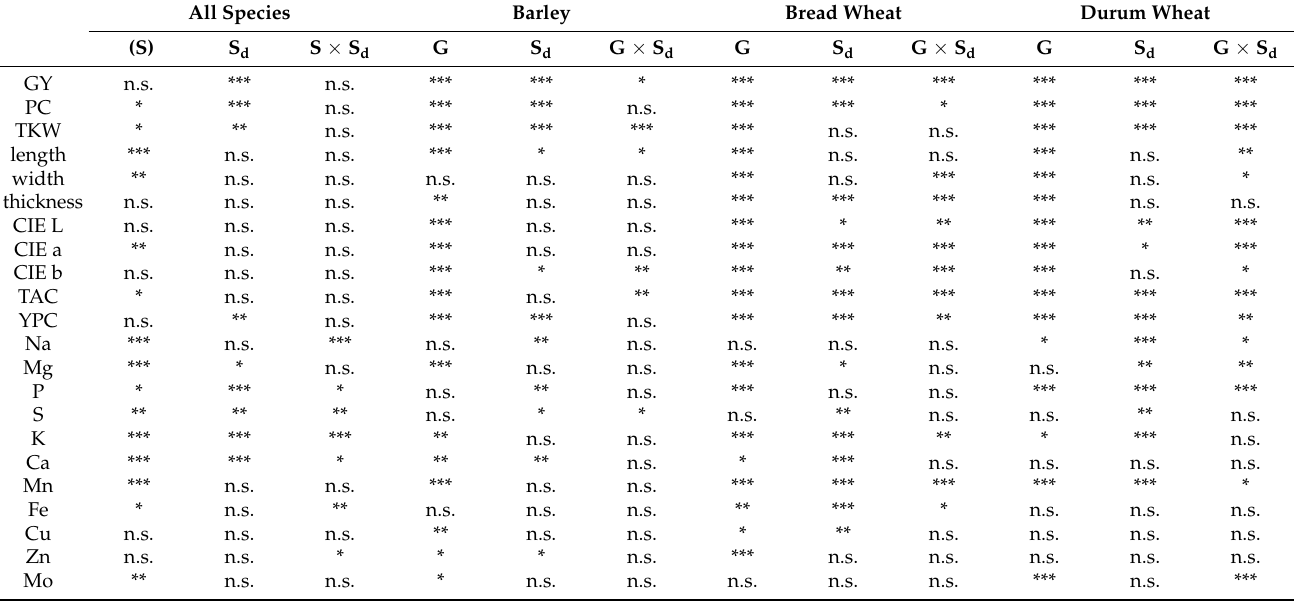
Table 4. Significances of the mean differences for each variable investigated relating to the whole data set and specific to each species, grown with two different sowing dates. Barley Bread Wheat Durum